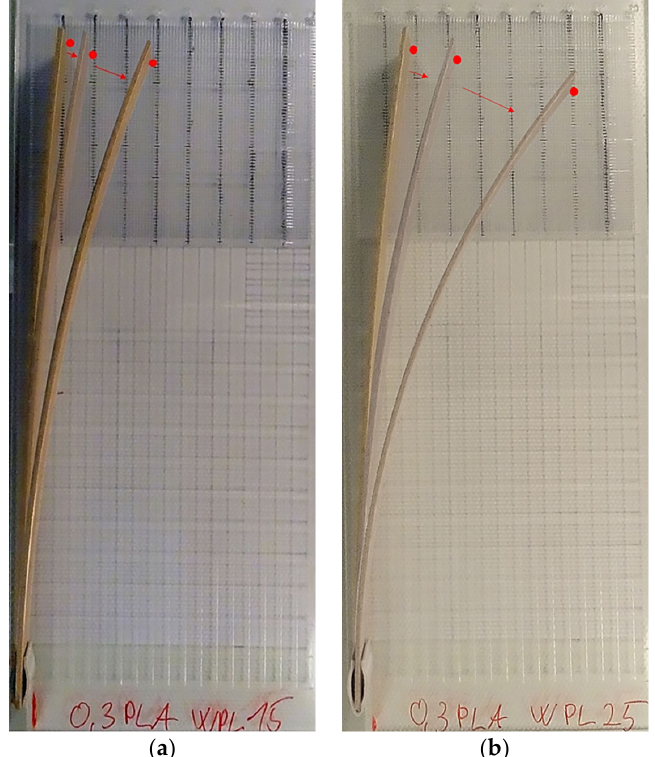
Figure 6. Deflection of the sample 0.3PLA WPL15 (m = 0.2) ( a ) and sample 0.3PLA WPL25 (m = 0.2) ( b ) from the initial position to 6 h (middle red dot) and at the end of humidification process (right red dot) (168 h at humid climate of 80% RH and 20 °C).